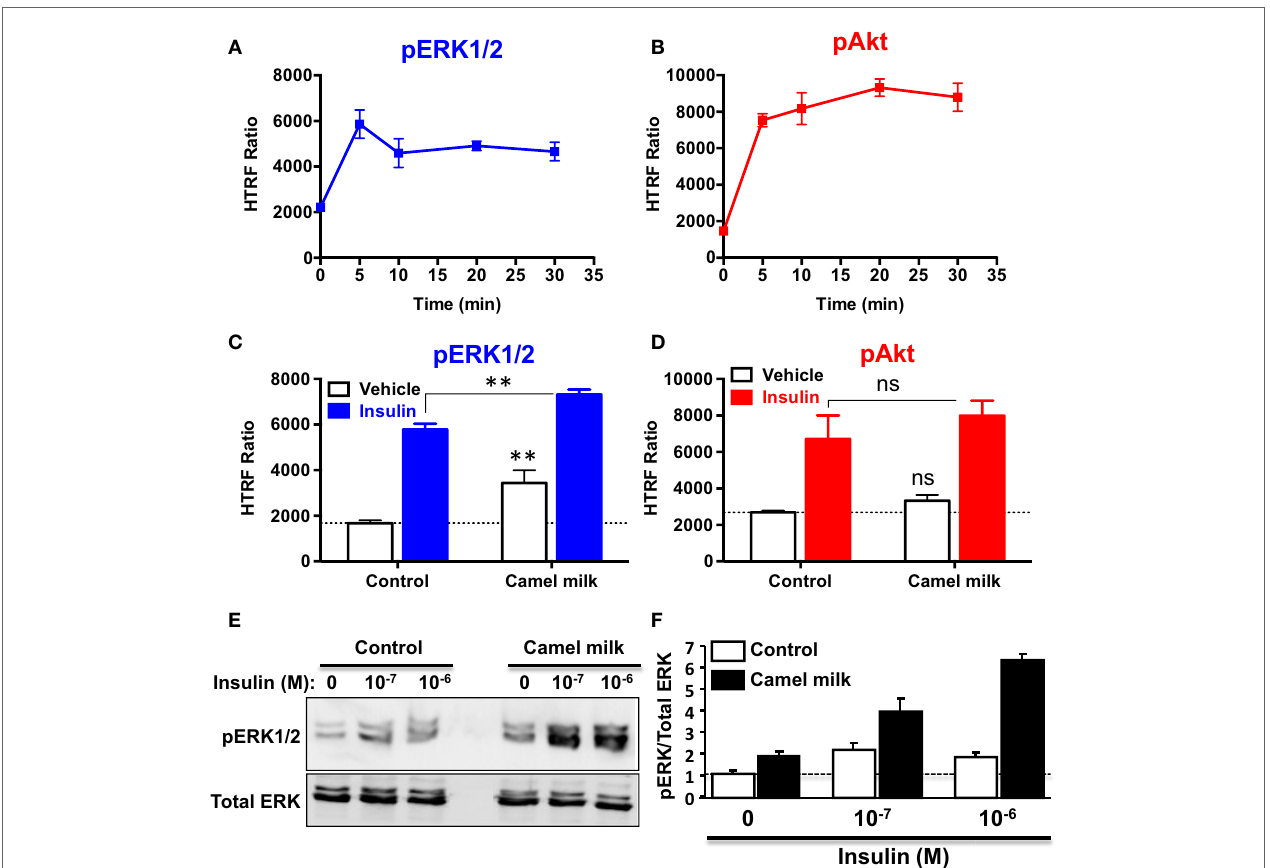
FigUre 6 | effect of camel milk on erK1/2 and akt phosphorylation. HEK293 cells transiently co-expressing hIR–Rluc8 and Grb2–Venus were used for ERK1/2 and Akt phosphorylation using the HTRF ® -based assay (a–D) and SDS-PAGE/western blot technique (e,F) . First, time-course analysis of phospho-ERK1/2 (a) and phospho-Akt (B) upon stimulation with 100 nM of insulin at different times was performed and HTRF signals were measured as described in Section “Materials and Methods.” Next, cells were first pre-treated or not 30 min with camel milk and stimulated or not 5 min with 100 nM of insulin before HTRF signals were measured as indicated. For the western blot analysis, cells were first pre-treated or not 30 min with camel milk and stimulated or not 5 min with 100 or 1 μ M of insulin before SDS-PAGE and western blot using a rabbit polyclonal antibody against phospho-ERK1/2 (Thr202/Tyr204) (e) . The western blot signals were quantified and expressed in arbitrary units after normalization (F) . The HTRF data are mean ± SEM of three (for Akt) and four (for ERK1/2) independent experiments performed in triplicate. The western blot data are representative of two